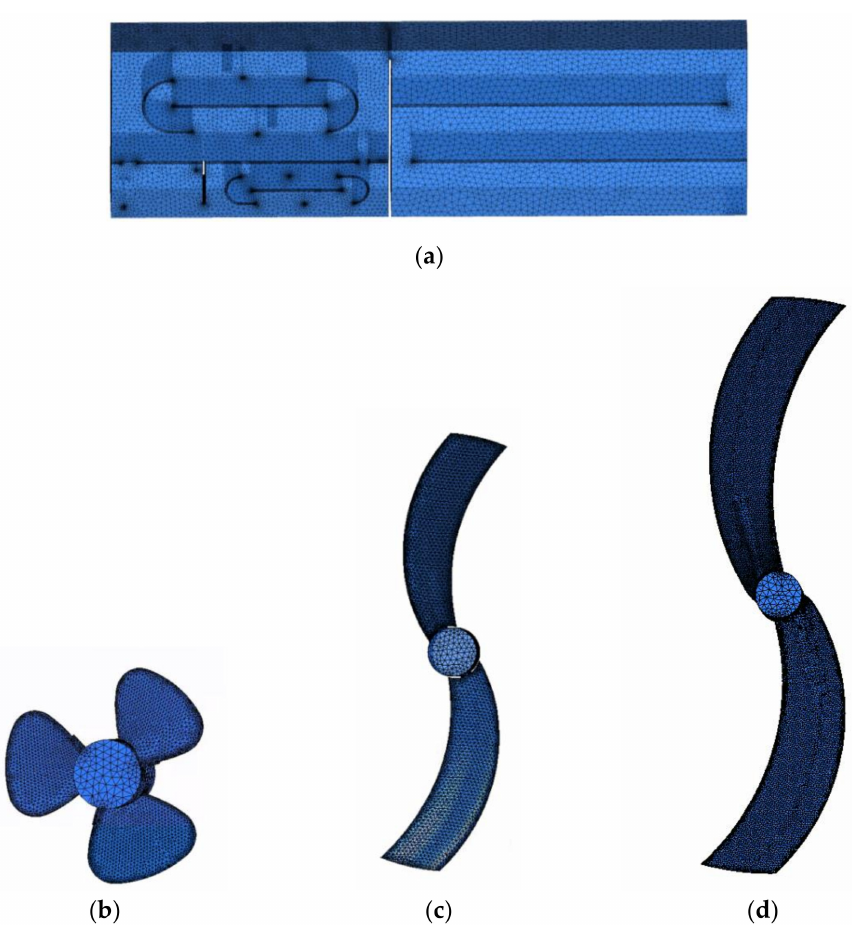
Figure 2. Meshed channel and blades of the OD. ( a ) The whole flow channel; ( b ) Agitators; ( c ) Pro-